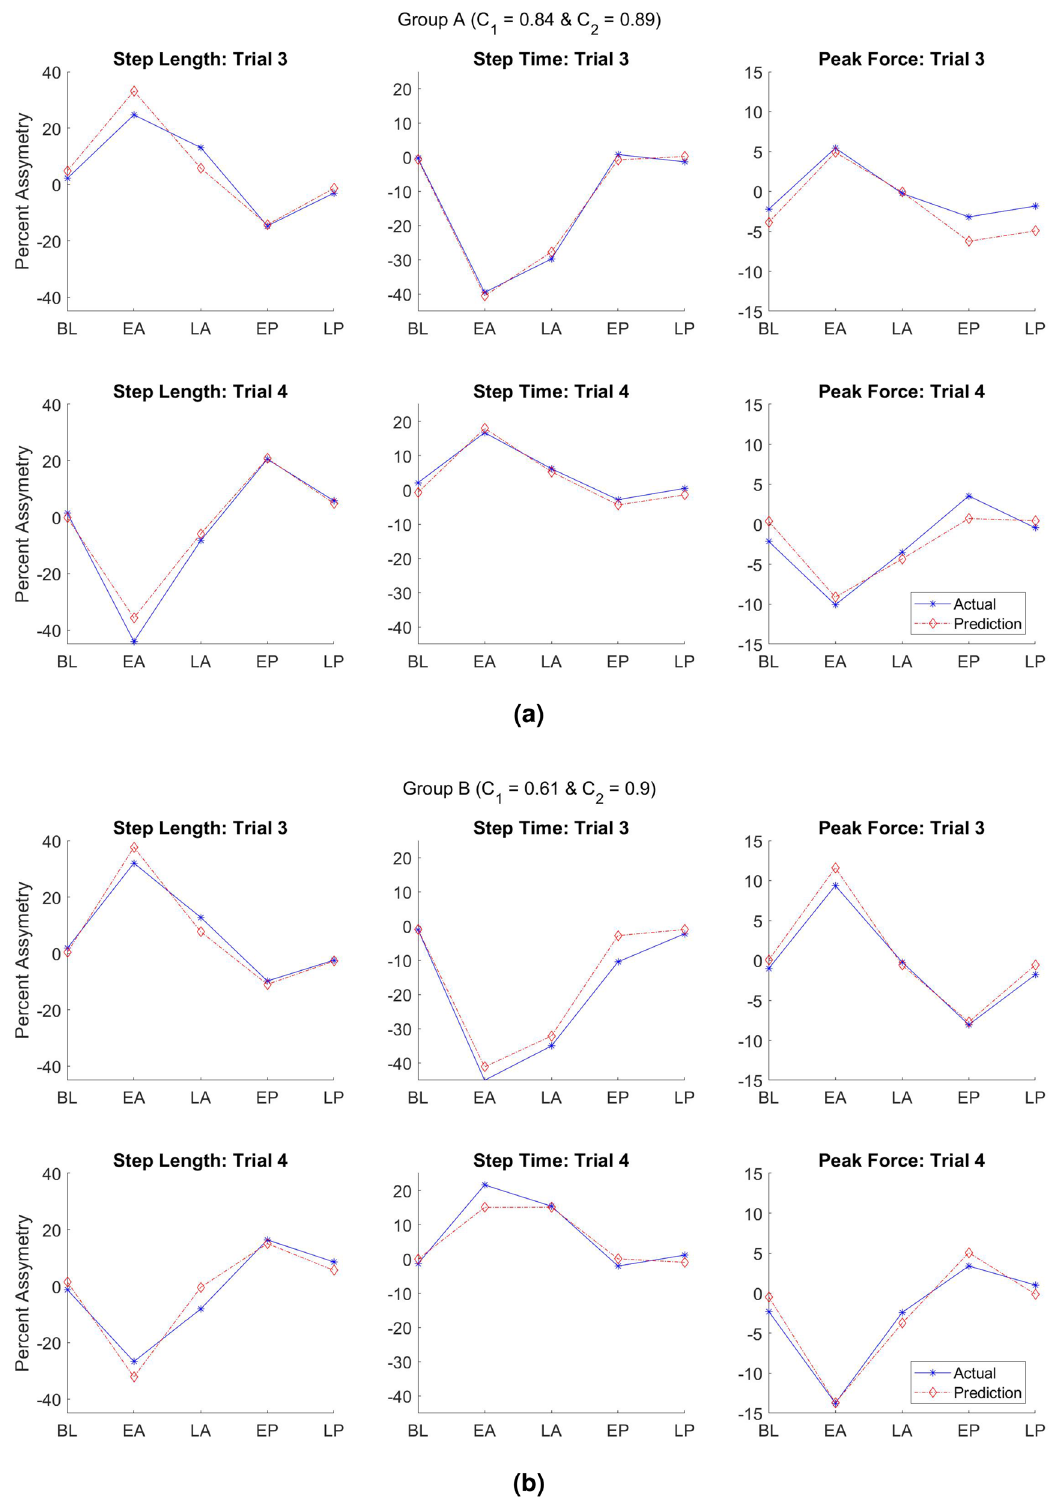
Figure 4. Linear model predicting the asymmetric performance of step length, step time, and peak vertical force compared to real data during trial 3 and 4. The predictions are the dashed red lines, and the actual results from experiments are solid blue lines. ( a ) Group A actual data and model with the coefficients C1 = 0.84 and C2 = 0.89, ( b ) Group B actual data and model with the coefficients C1 = 0.61 and C2 = 0.90. The top row in each group represents the linear model and real data for the congruent combination (trial 3), and the bottom row represents the linear model and real data for the incongruent combination (trial